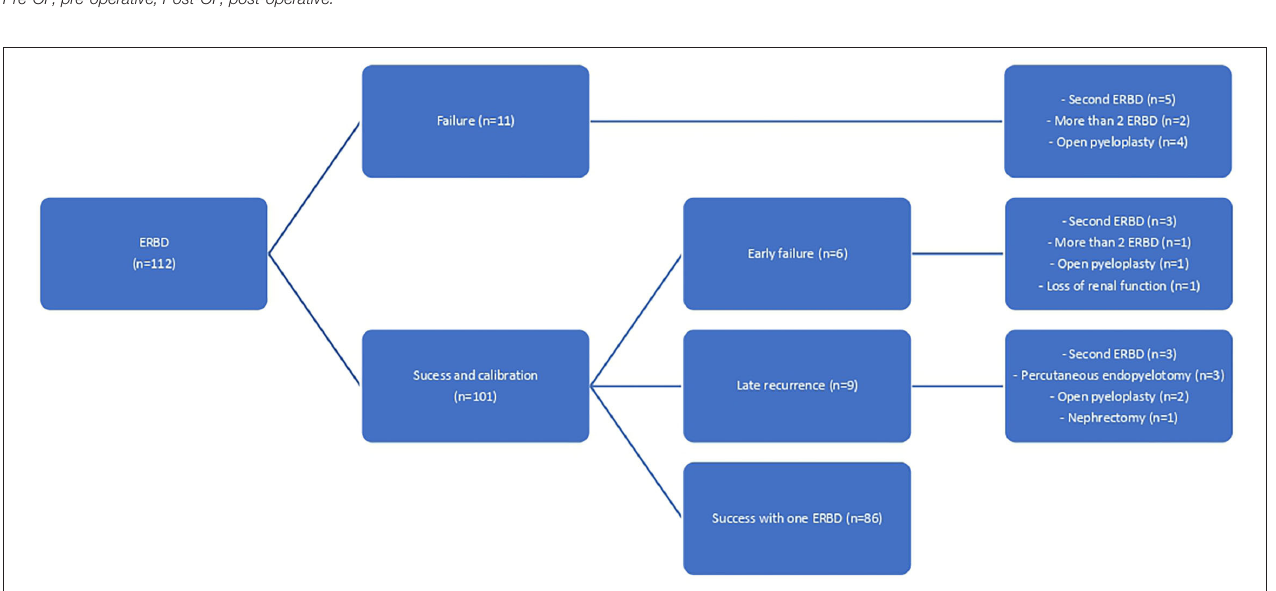
FIGURE 2 | Long and short-term